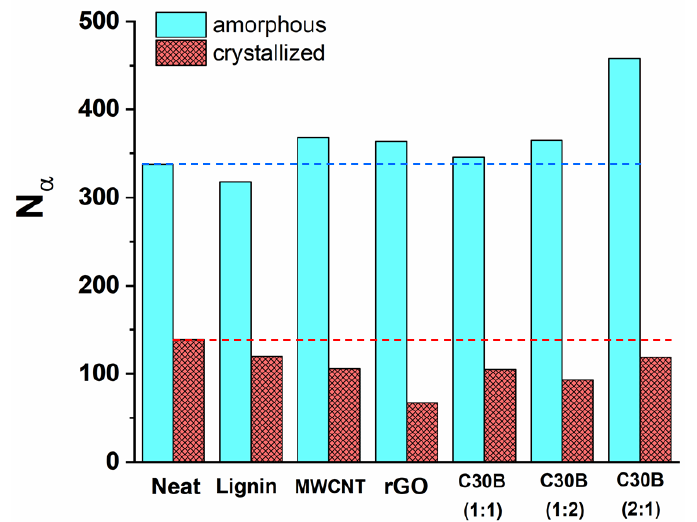
Figure 5. Number of relaxing units per CRR in amorphous and semi-crystalline PLLA and nanocomposites. Dashed lines are a guide, showing N α for amorphous neat PLLA.